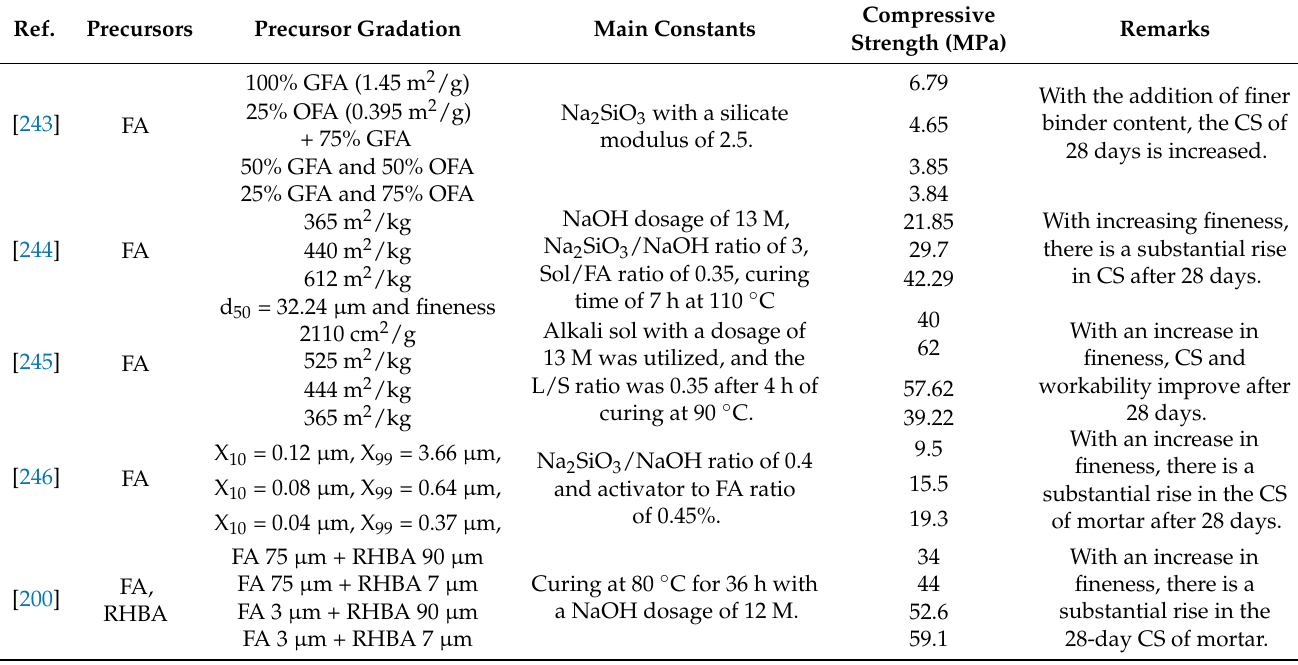
Table 6. Impact of the particle size distribution of precursors on FA-GP concrete